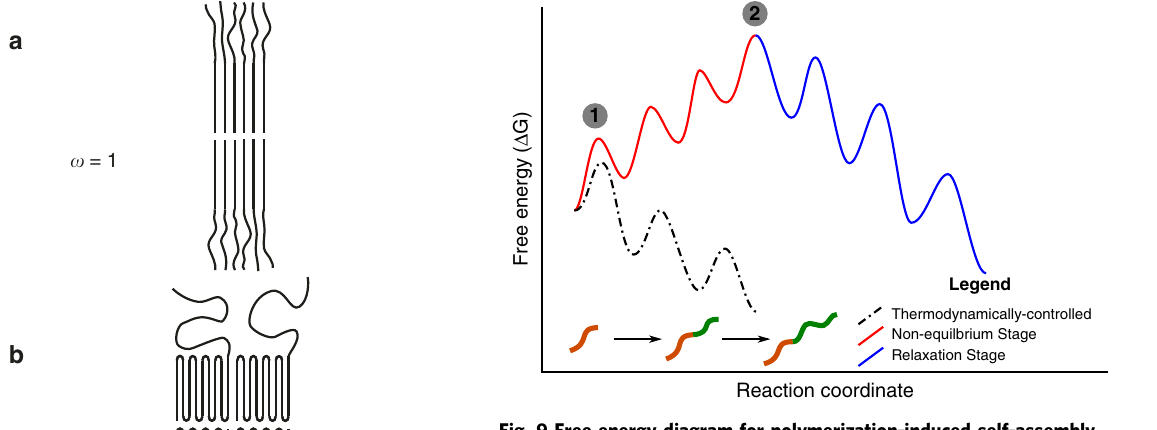
Fig. 9 Free energy diagram for polymerization-induced self-assembly. The dashed lines represent the situation where the relaxation time is short compared to the polymerization time. Consequently, with each monomer addition, the growing block copolymer relaxes to a lower energy con fi guration. The result is that the reaction proceeds downhill and fi nishes when the polymerization terminates. The solid line represents the situation where the polymerization time is much shorter than the relaxation time. Fig. 8 Polymer chain stretching. a When ω = 1 giving a dense corona and b